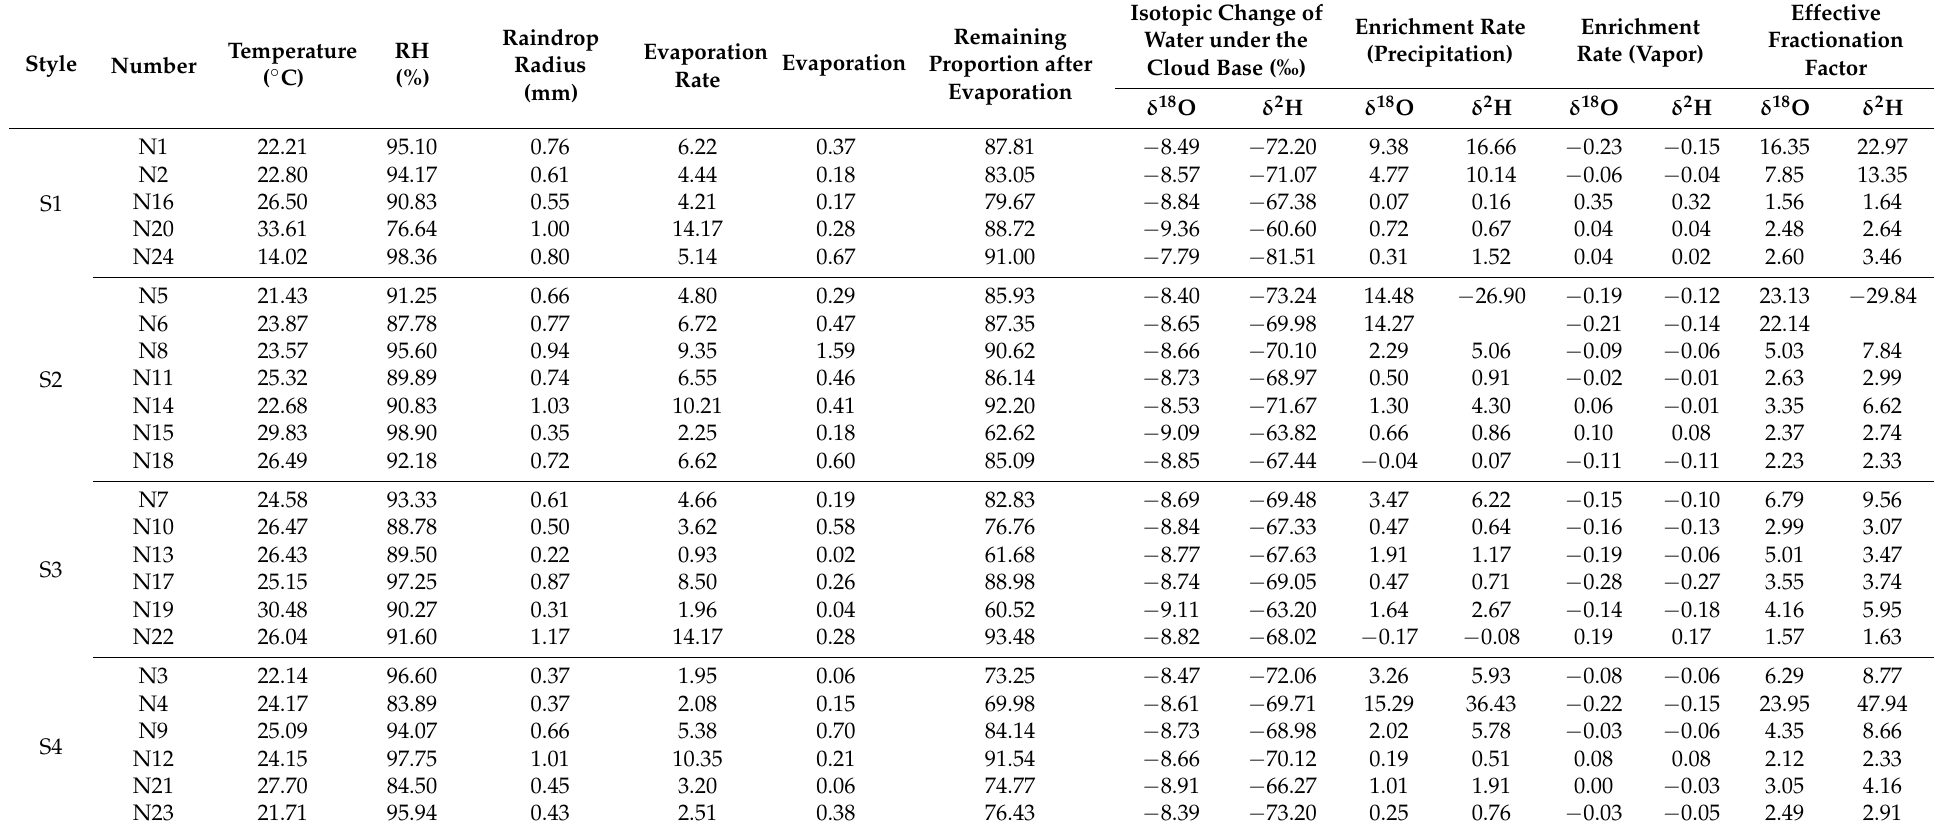
Table 2. Enrichment rate of heavy isotopes and the effective fractionation factor for different styles of rain